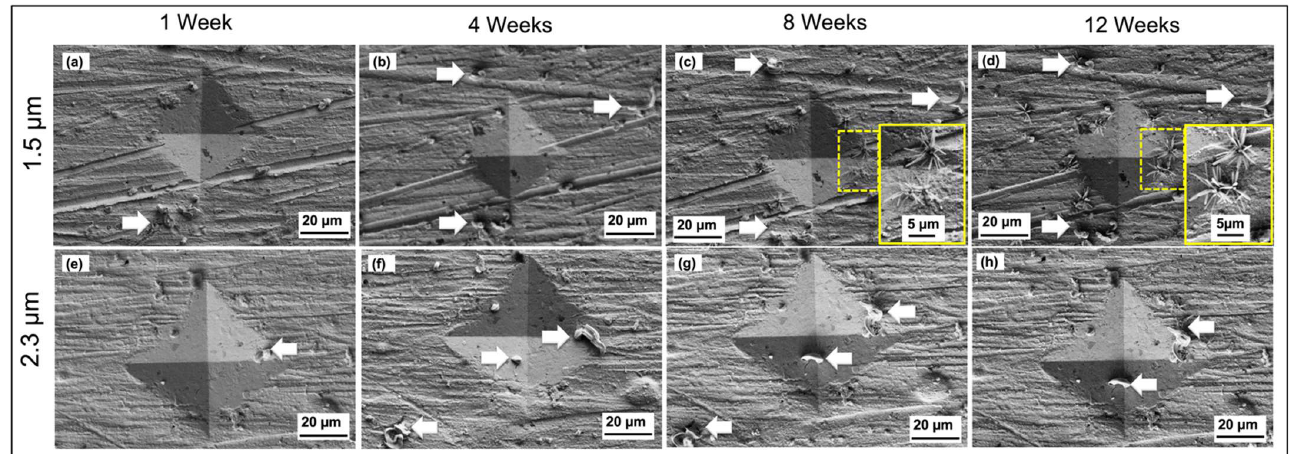
Figure 5. FESEM micrographs of tin whiskers observed on the indented surface of 1.5 µm ( a – d ) and 2.3 µm ( e – h ) tin coatings after 1 week up to 12 weeks of storage time.